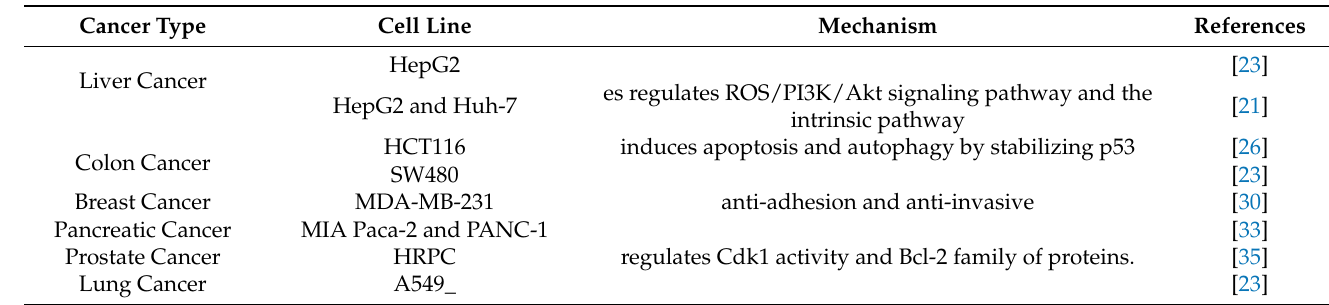
Table 2. Anti-cancer activities of